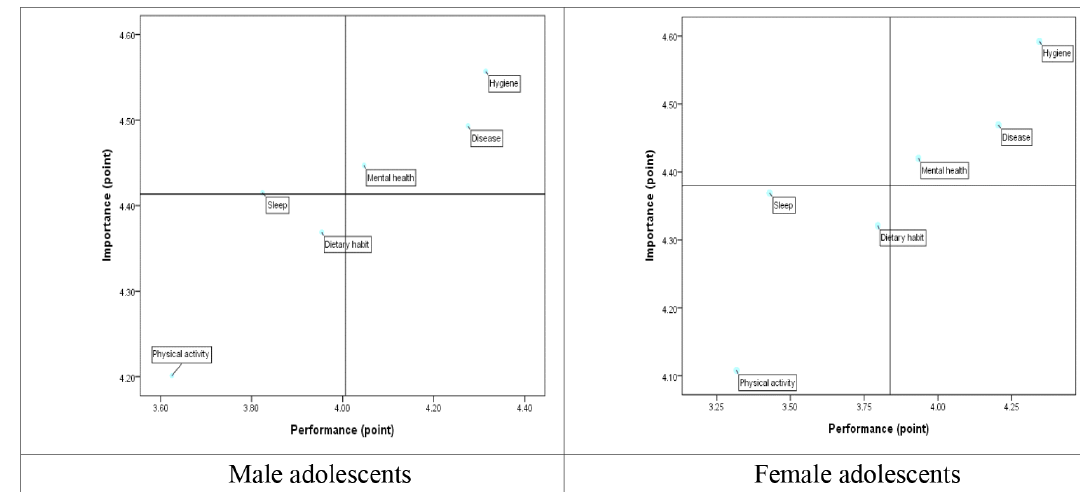
Fig. 3. IPA Matrix – Factors